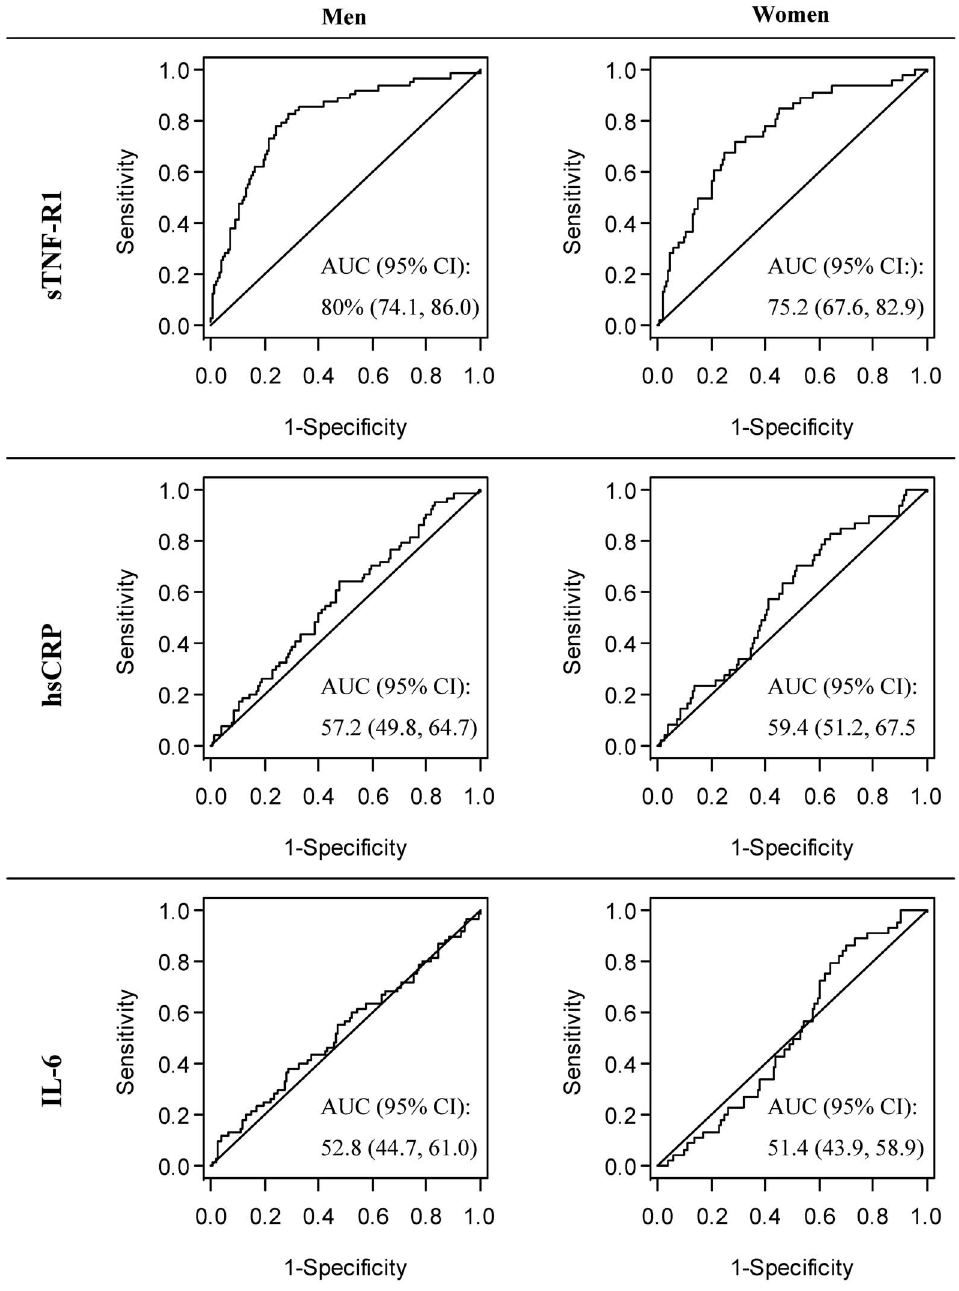
Figure 3. ROC curves and respective AUCs [95% confidence intervals]. Abbreviations: sTNF-R1: Soluble tumour necrosis factor- a receptor 1; hsCRP: High- sensitivity C-reactive protein; IL-6: Interleukin 6; CI: confidence interval.